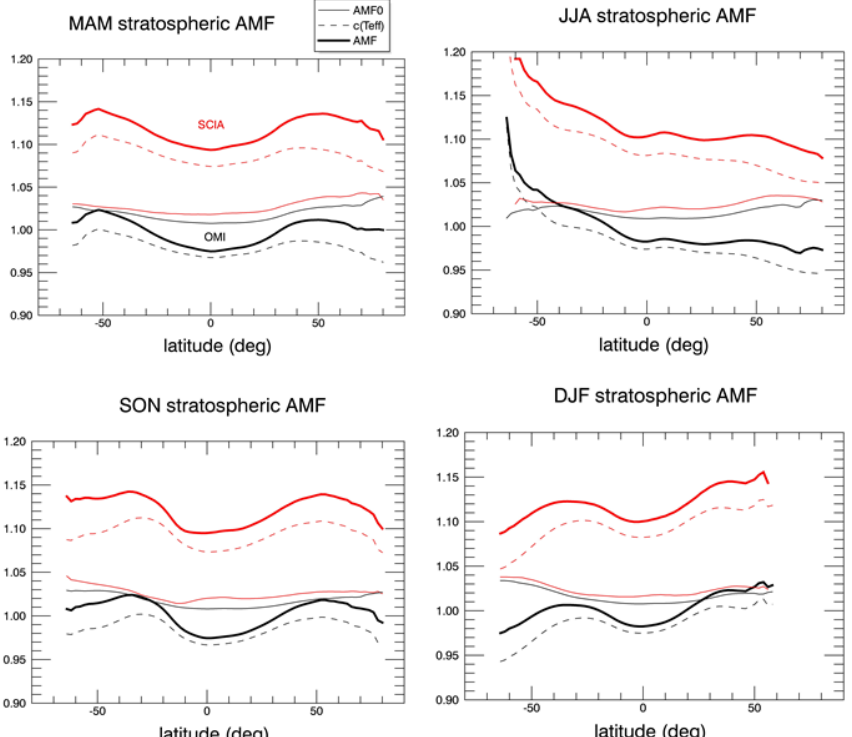
Figure 12. Average (MAM, JJA, SON and DJF) stratospheric air mass factors for 2005 plotted as a function of latitude for OMI (black) and SCIAMACHY (red) with components split into normalized scattering air mass factor M 0 (thin continuous), temperature correction factor (dashed) and total stratospheric air mass factor M strat (thick